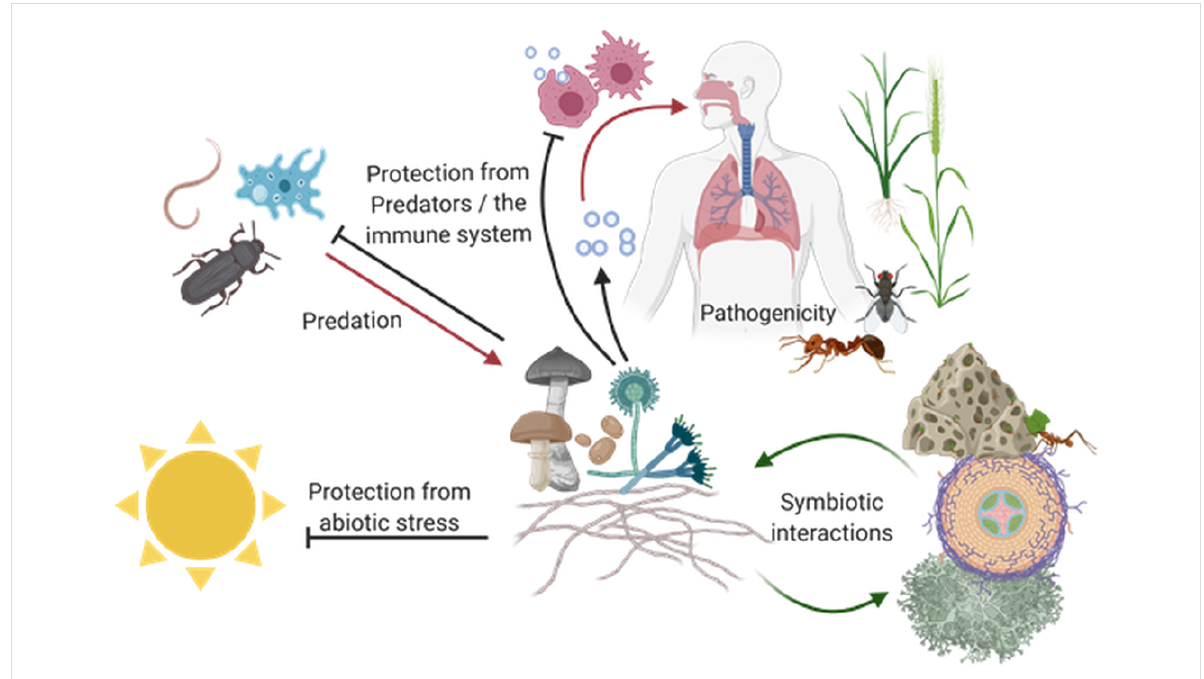
Figure 1: Schematic overview of fungal interactions in the environment. Fungi can be found in essentially all terrestrial habitats comprising sapro- phytic, parasitic, symbiotic or predatory lifestyles [6]. Independent of their ecological niche, they have to protect themselves against abiotic stresses, competitors and predators while also communicating with their host or partners during parasitic/pathogenic or symbiotic interactions. This figure was created with